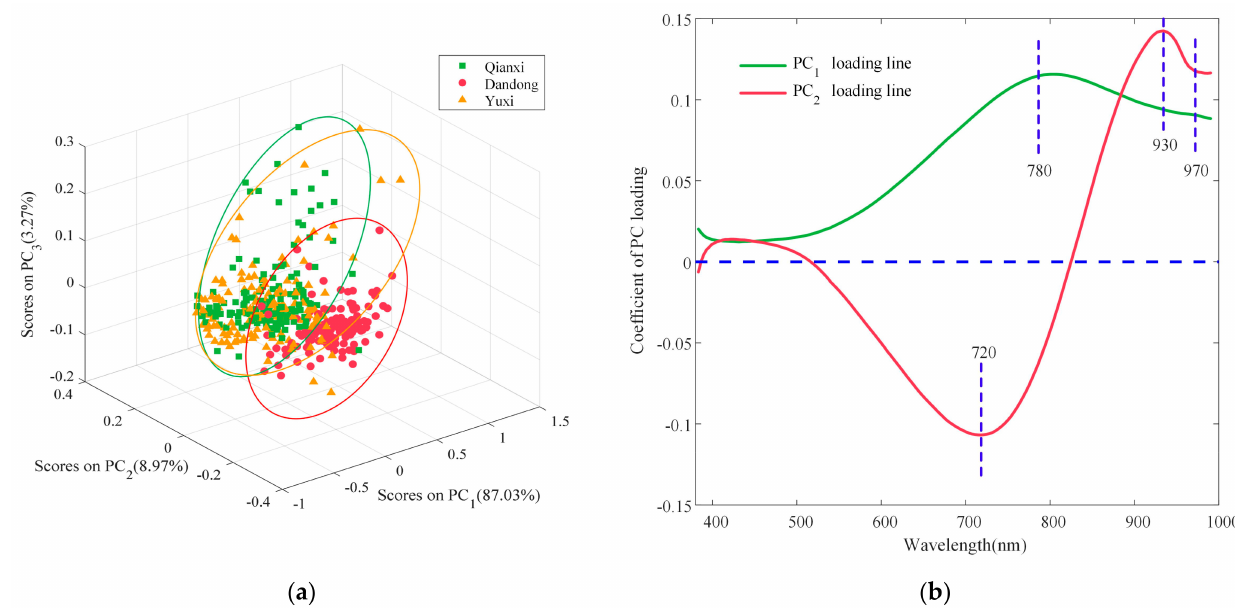
Figure 4. Spectral PCA for Chinese chestnuts with different varieties. ( a ) The first three PC score plots, and ( b ) the first two PC loading lines. PCA, principal component analysis, and PC, principal component.